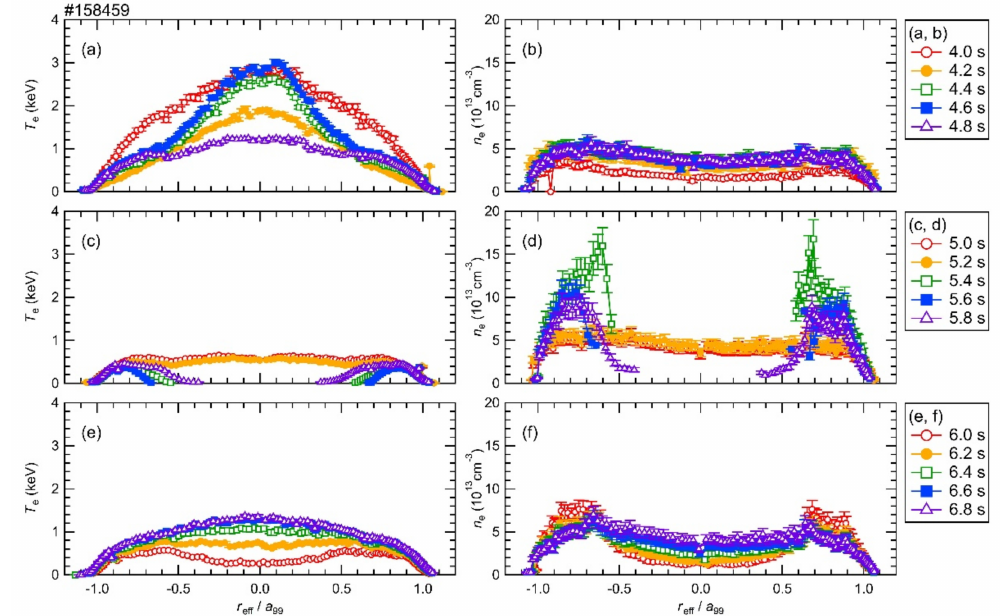
Figure 3. Temporal evolutions of radial profiles of electron temperature, T e , and electron density, n e , ( a , b ) for 4.0–4.8 s, ( c , d ) for 5.0–5.8 s, and ( e , f ) for 6.0–6.8 s plotted against effective minor radius, r eff , normalized by a 99 . Locations of r eff / a 99 = ± 1 are plasma